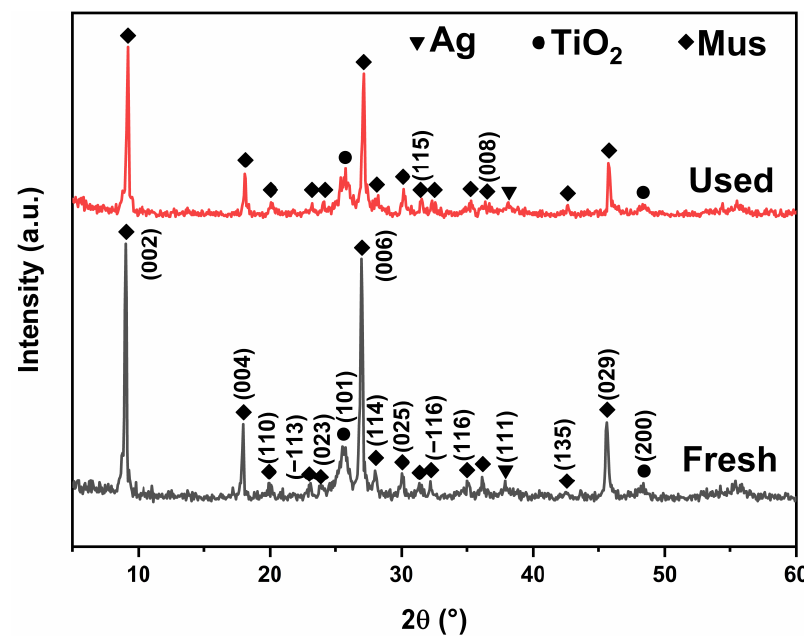
Figure 11. XRD patterns of 1-ATM photocatalyst before and after the photocatalytic experiment.